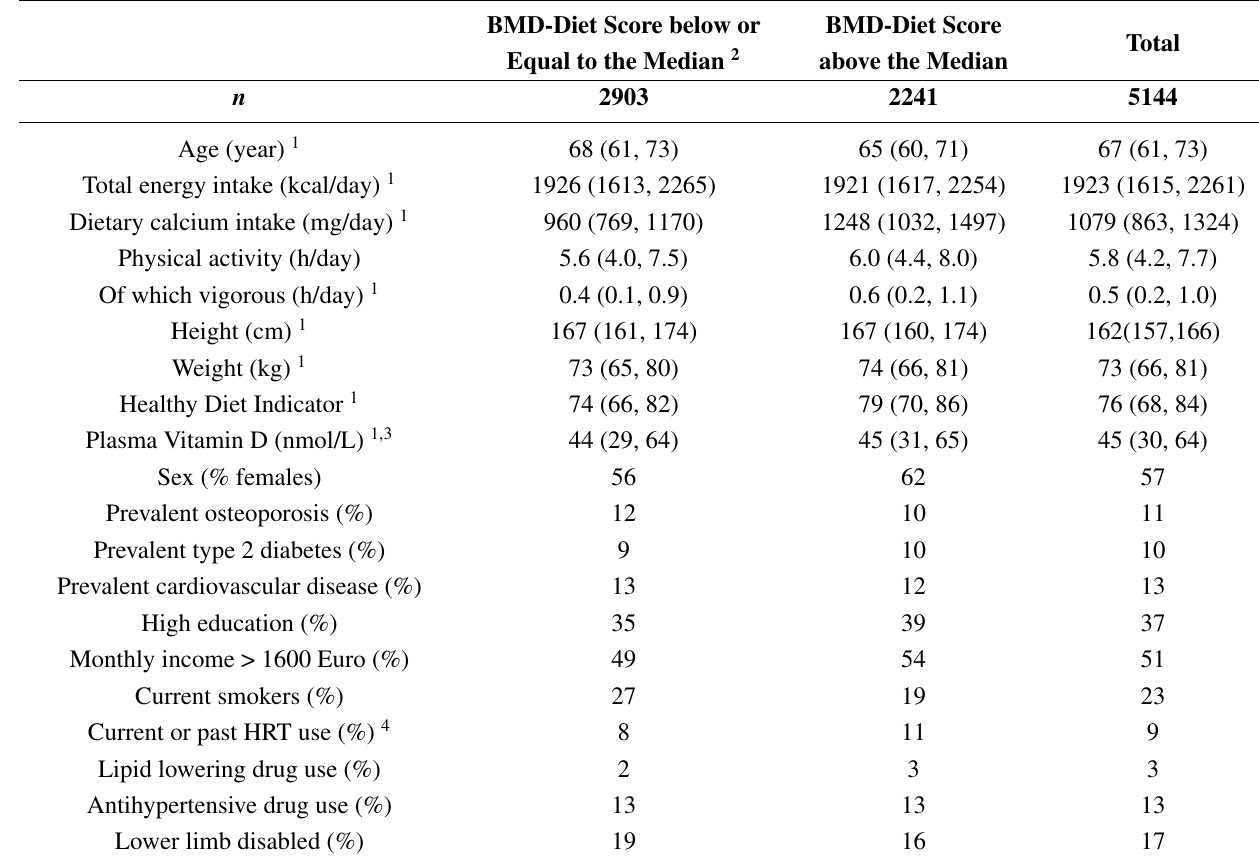
Table 2. Characteristics of the study population in participants with a BMD-Diet